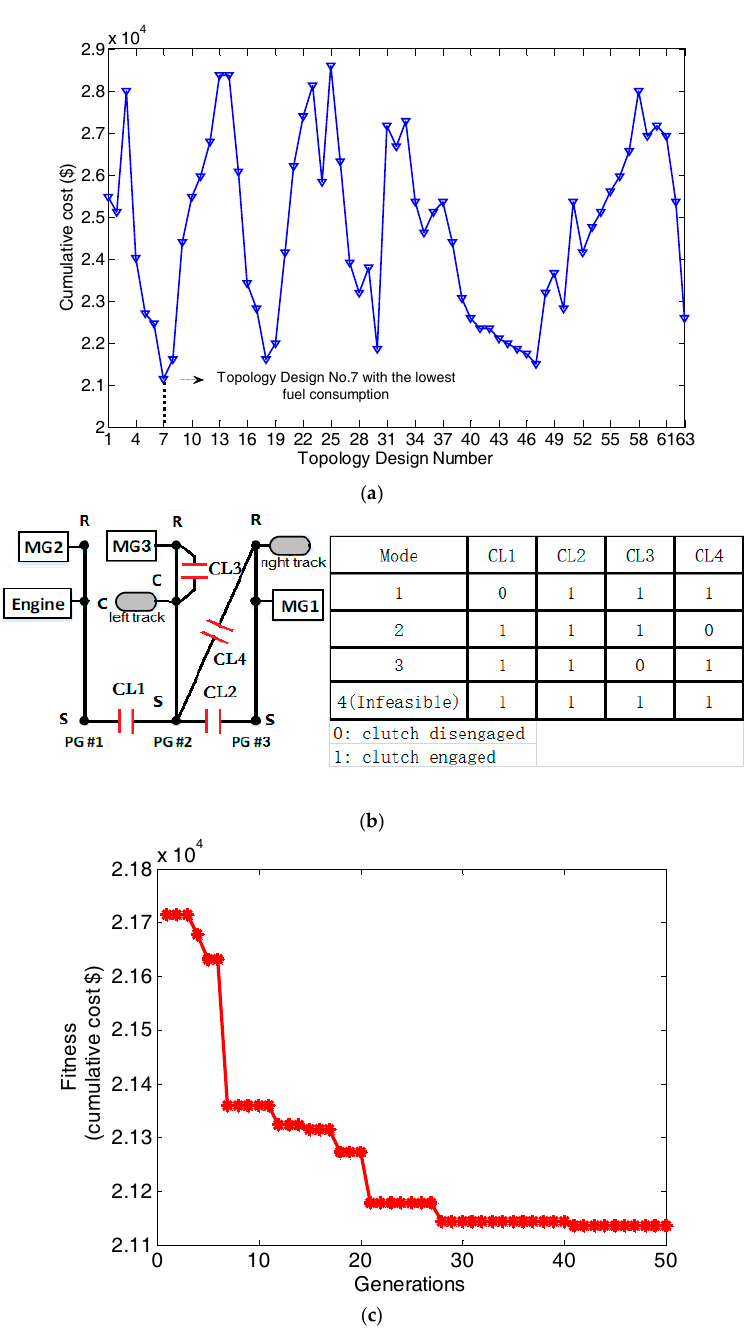
Figure 15. Optimization result: ( a ) results of all topologies, ( b ) lever diagram of the final design, ( c ) size optimization result of the final design.